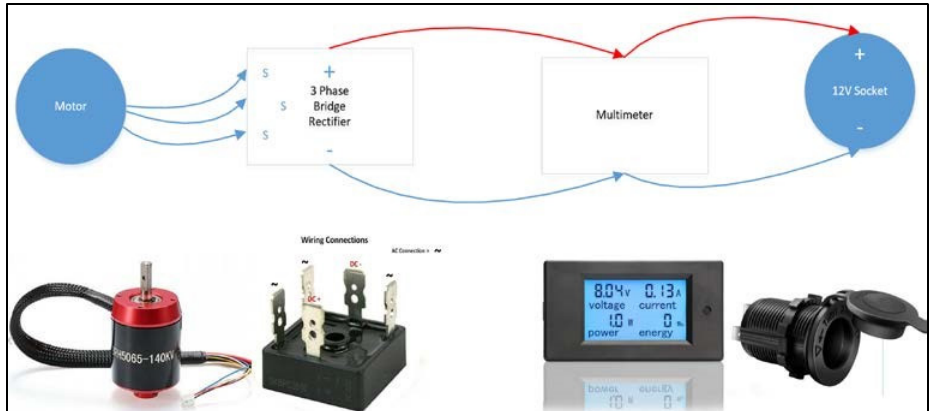
Figure 9. Convert AC to DC with a 3-phase bridge rectifier.